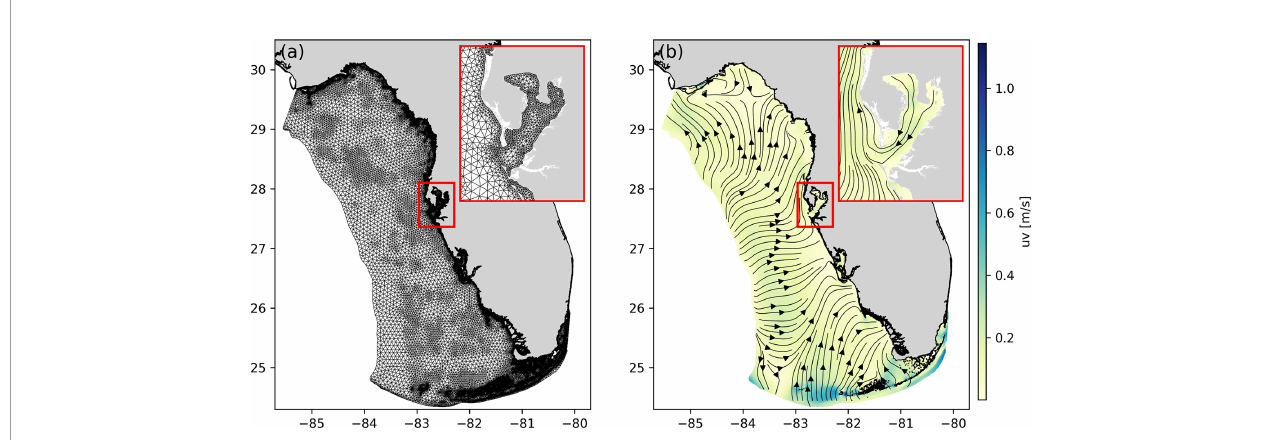
FIGURE 2 | Model computational domain with a close-up view on Tampa Bay showing (A) the horizontal unstructured mesh whose resolution ranges between 400m and 10km and (B) a snapshot of the surface circulation as modelled by SLIM on the 15 th of July, 2019 at 00:00, with uv as the horizontal